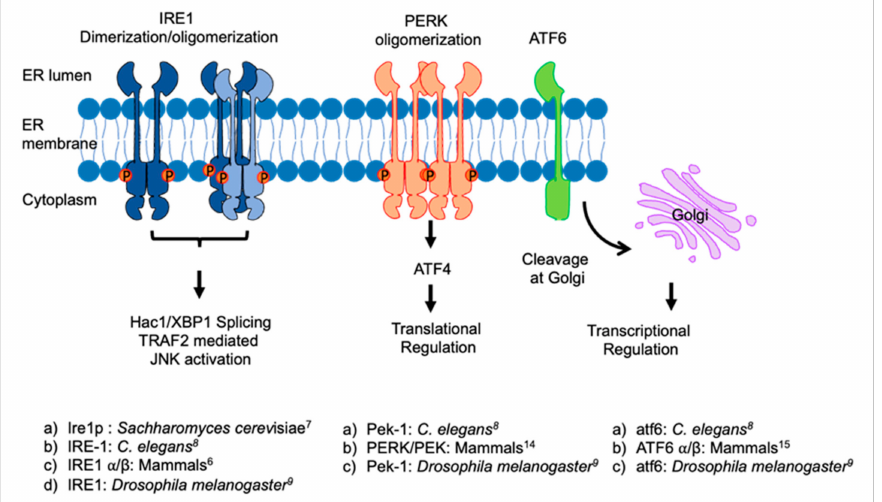
Figure 1. ER stress sensors are conserved from yeast to mammals. List (below) shows ER stress sensors in various model organisms. Numbers (in prefix) indicate the reference of the research